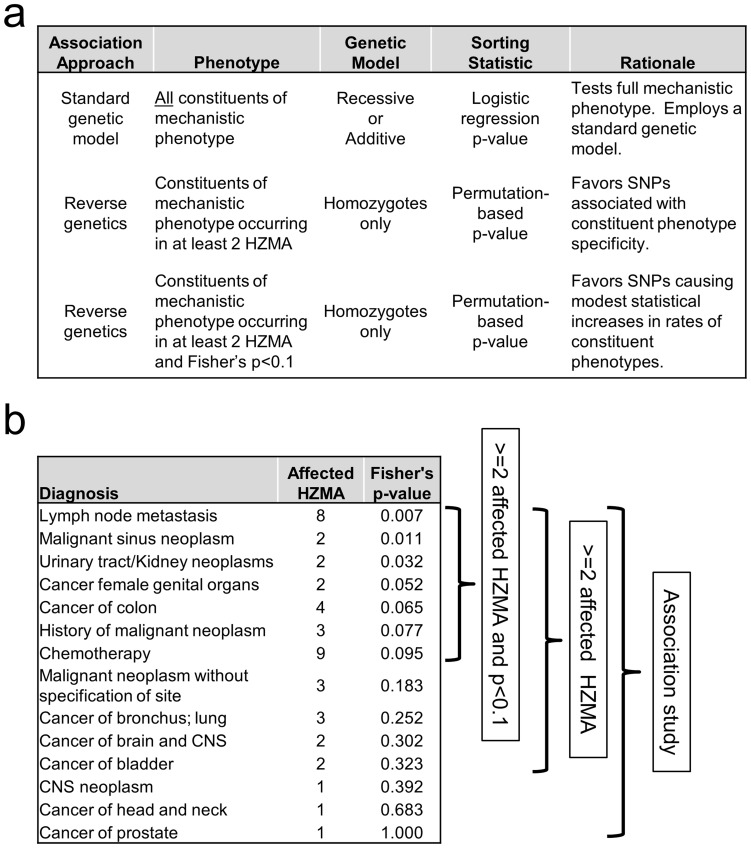
Overview of the nsSNP association approaches.Panel (a) describes key features of the SNP association approaches used. Panel (b) shows, for a single hypothetical SNP, how assignment of affection status for homozygotes for the minor allele (HZMAs) varies by the approaches. The table lists cancer codes present among the HZMAs, the number of HZMAs that have the cancer code and the Fisher's p-value comparing the proportion of affected HZMAs with the cancer to the proportion in the common allele homozygotes. For this example, all of the listed cancers are assumed to be constituents of the mechanistic phenotype. For the standard genetic models, all subjects with any of the cancers are classified as cases. In contrast, the 2 reverse genetics approaches only analyze subsets of these subjects with cancers meeting pre-specified criteria, as designated by the brackets.